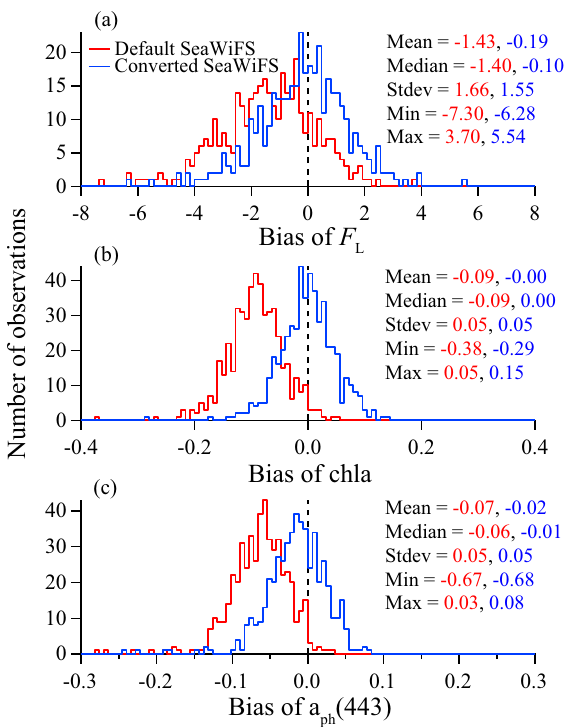
Figure A2. Histograms and statistics of the bias between SeaWiFS- and MODIS-retrieved (a) F L , (b) chl a , and (c) a ph (443). Red coloured lines and statistics denote the results from default SeaWiFS- R rs (λ) , and blue coloured lines and statistics denote the results from converted SeaWiFS- R rs (λ) . The products were signifi- cantly improved ( p <0.01) for means ( t test) and medians ( U test). Note that biases of chl a and a ph (443) were computed for the log- transformed values.